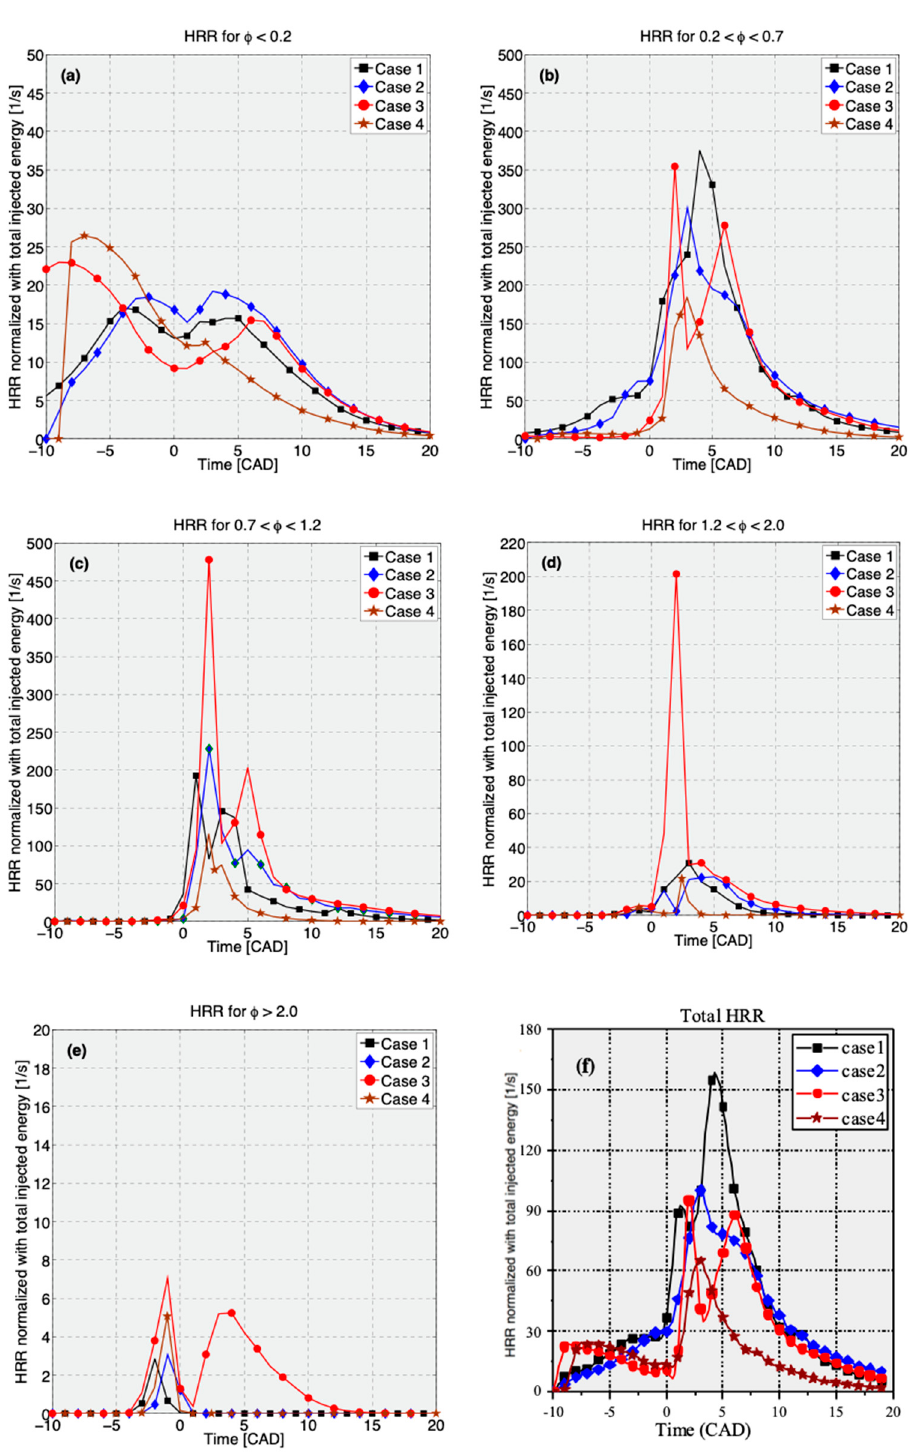
Figure 10. Normalized heat-release rate from the mixtures at various ranges of equivalence ratio ( a – e ) and total heat-release rates (HRR) from all equivalence ratios ( f ). The HRR is normalized with the total energy input of the fuel within the respective Φ -range. The adjusted initial temperatures are case 2: 15 K; case 3: 30 K; case 4: 30 K.